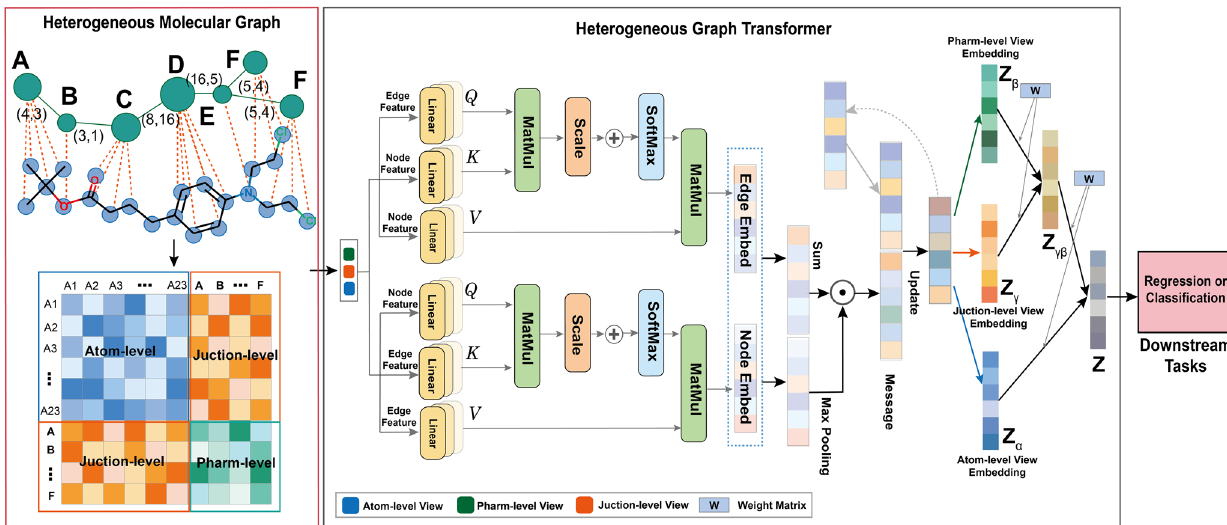
Fig. 2 Illustration of Pharmacophoric-Constrained Heterogeneous Graph Transformer for molecular property prediction (PharmHGT). Firstly, the heterogeneous molecular graph is formalized as the feature matrix. Then, the feature matrix of each view will fi rst do message passing independently to obtain the graph feature matrix of each view. Finally, the junction_view feature matrix will fi rst do attention aggregation with the pharm_view feature matrix to obtain the aggregation feature matrix, then that matrix will do attention aggregation with the atom_view feature matrix, and fi nally, obtain the features of each node, and input those nodes as a sequence into the GRU to get the representation vector of the entire small